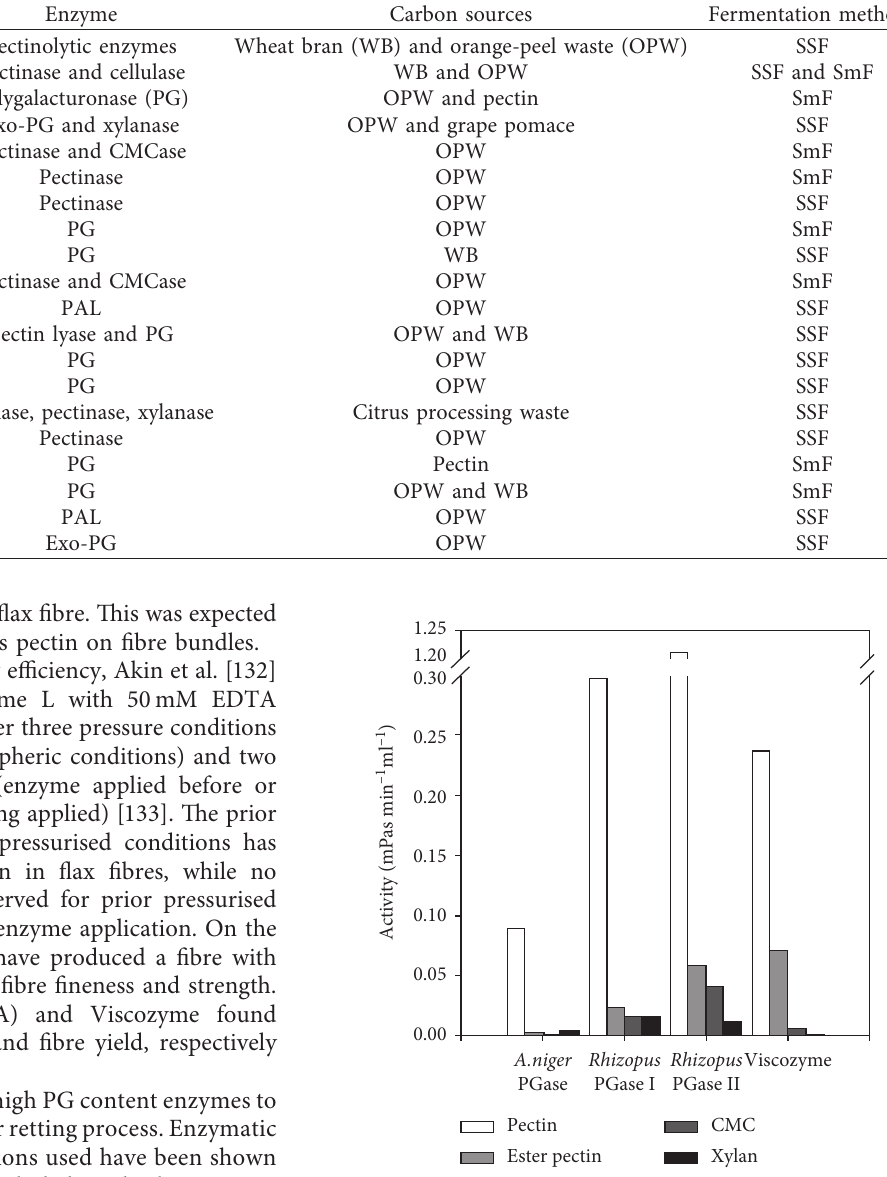
Figure 12: PG activities of enzymatic solutions